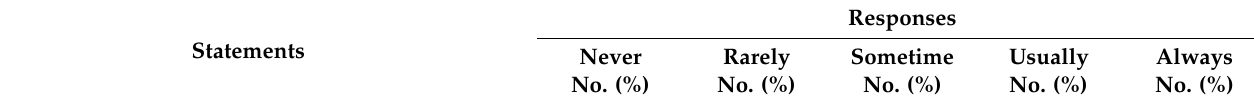
Table 4. Physicians’ responses to attitude statements on